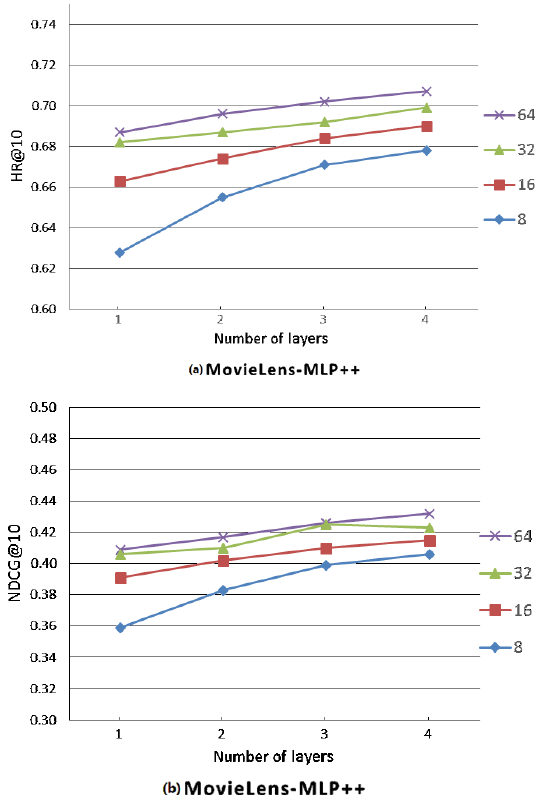
Fig. 8 Performances of HR@10 and NDCG@10 w.r.t. the number of hidden